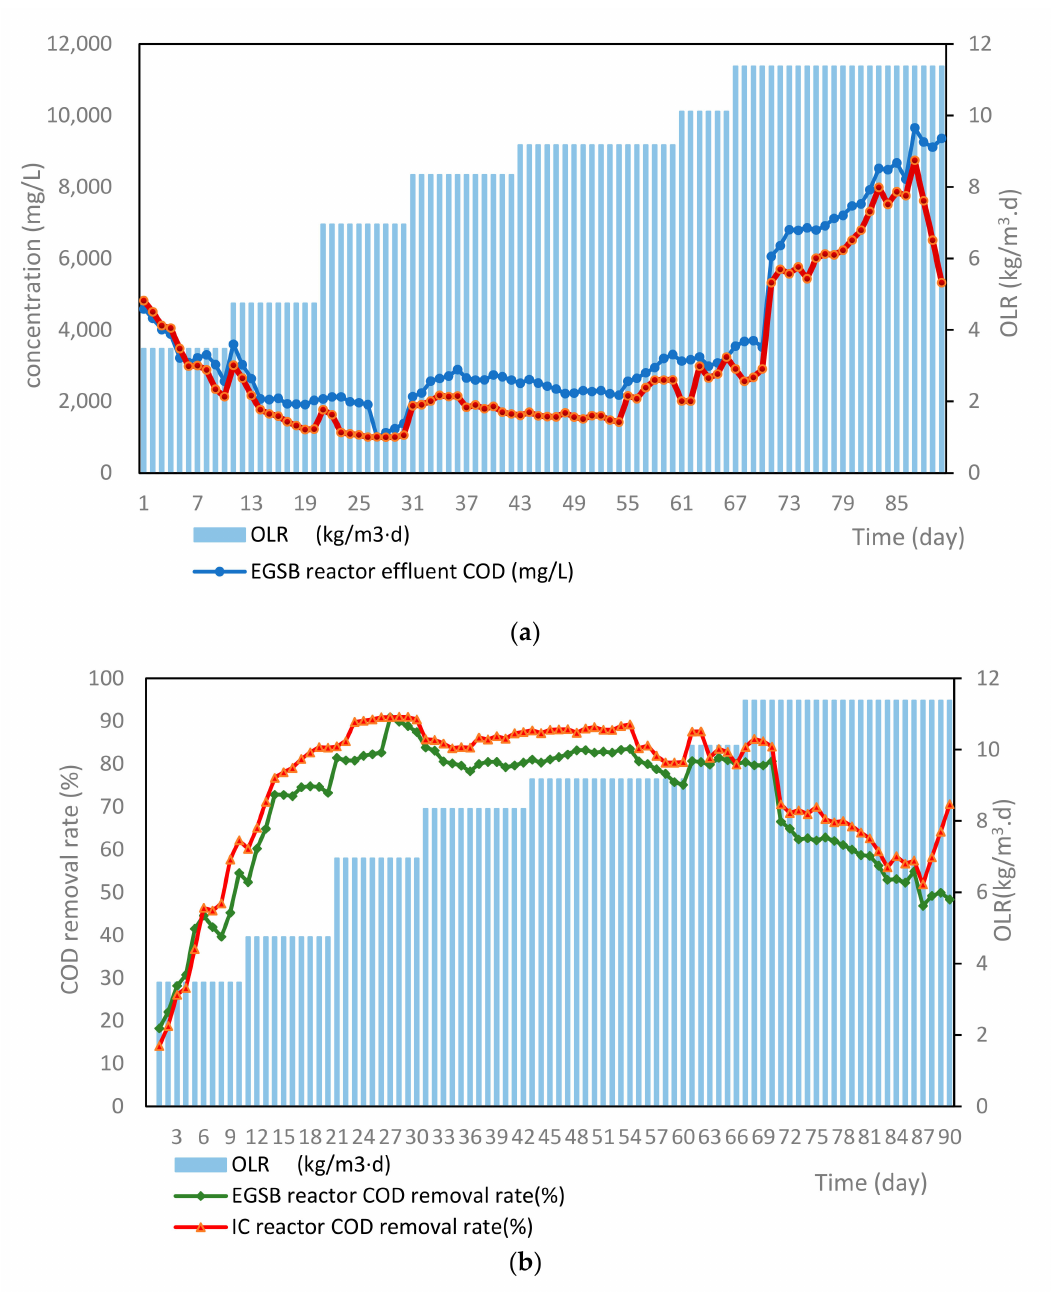
Figure 5. Relationship between organic load and reactor COD removal rate. ( a ) Relationship between OLR and COD concentration of reactor effluent and the comparison of two reactors. ( b ) Relationship between OLR and reactor COD removal rate and the comparison of two